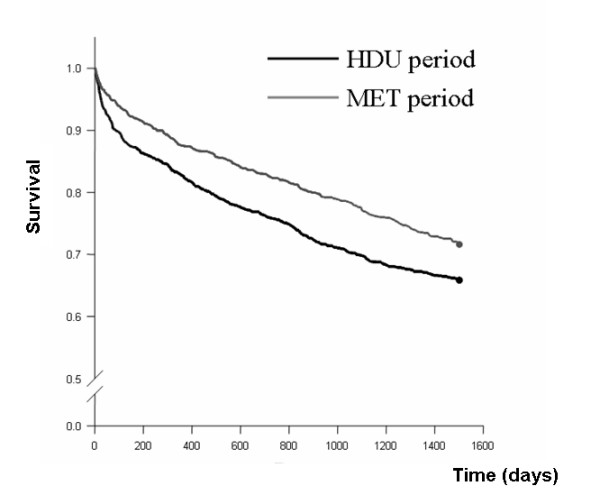
Kaplan-Meier survival curves for patients admitted during control and MET periods to 1500 days. MET, medical emergency team.